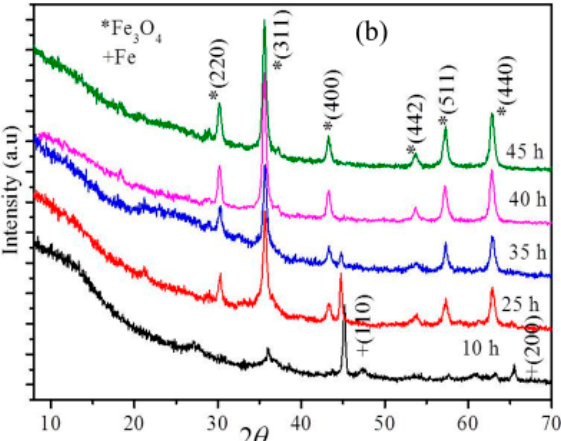
Figure 1. ( a ) X-ray diffraction (XRD) profiles obtained from milled graphene oxide and Fe nanocomposite with GO-Fe compositions 20:80, 50:50, and 80:20. ( b ) XRD patterns of GO-Fe (50:50) nanocomposite milled for 10, 25, 35, 40, and 45 h.